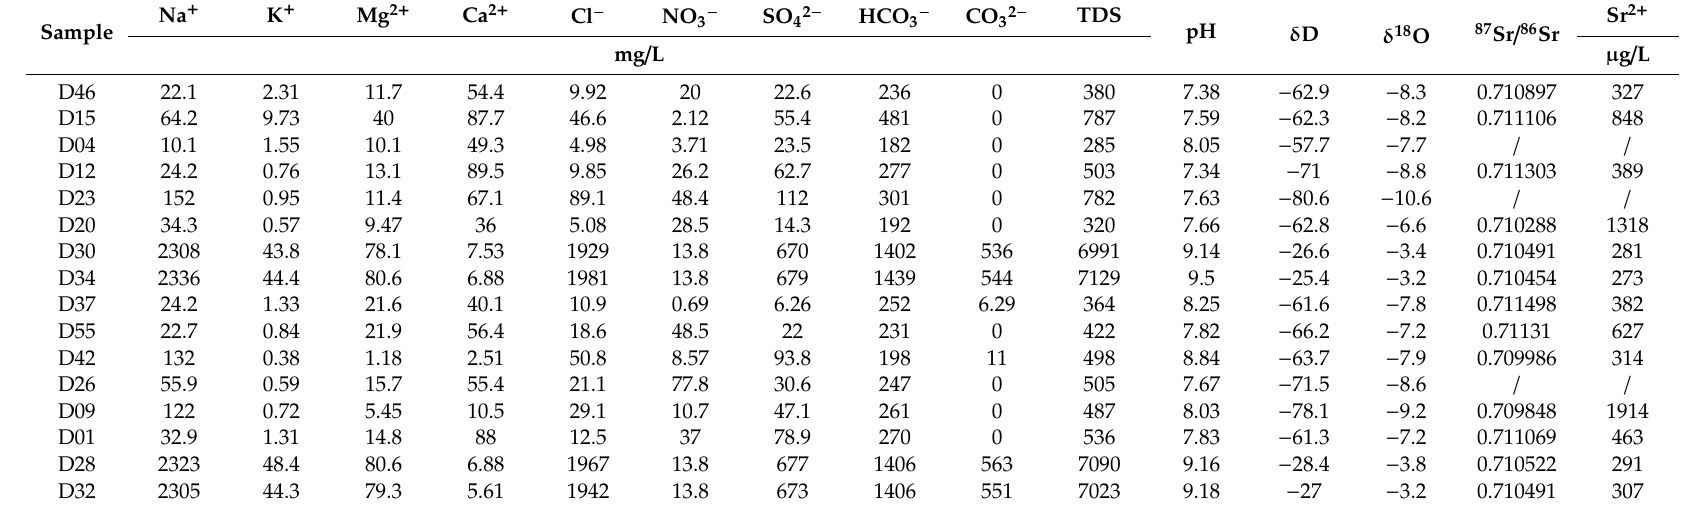
Table A1. Statistical summary for the hydrochemical parameters and isotopes of water samples (sample locations shown in Figure